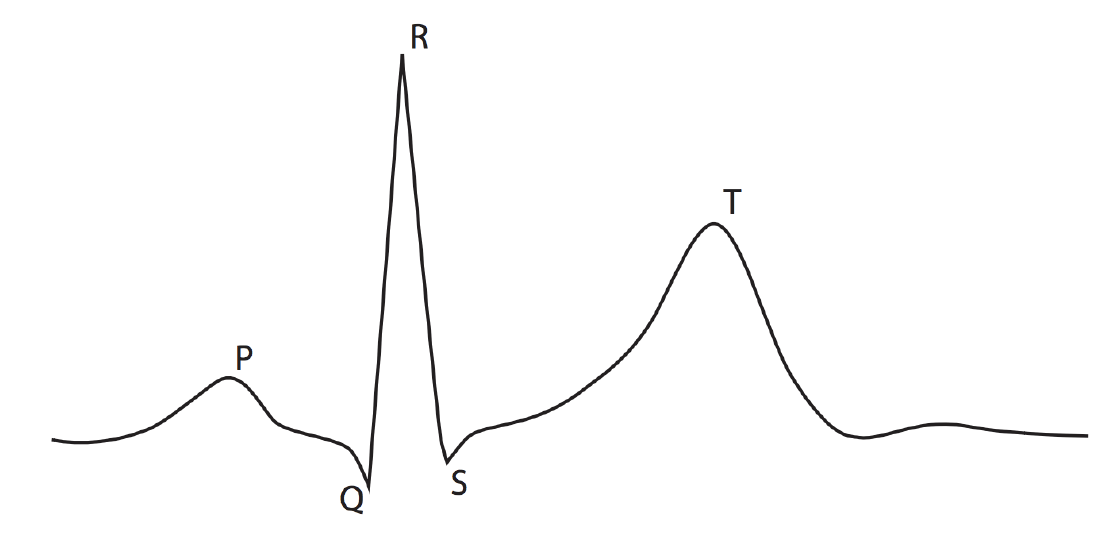
Figure 3. An example Electrocardiography (ECG) signal